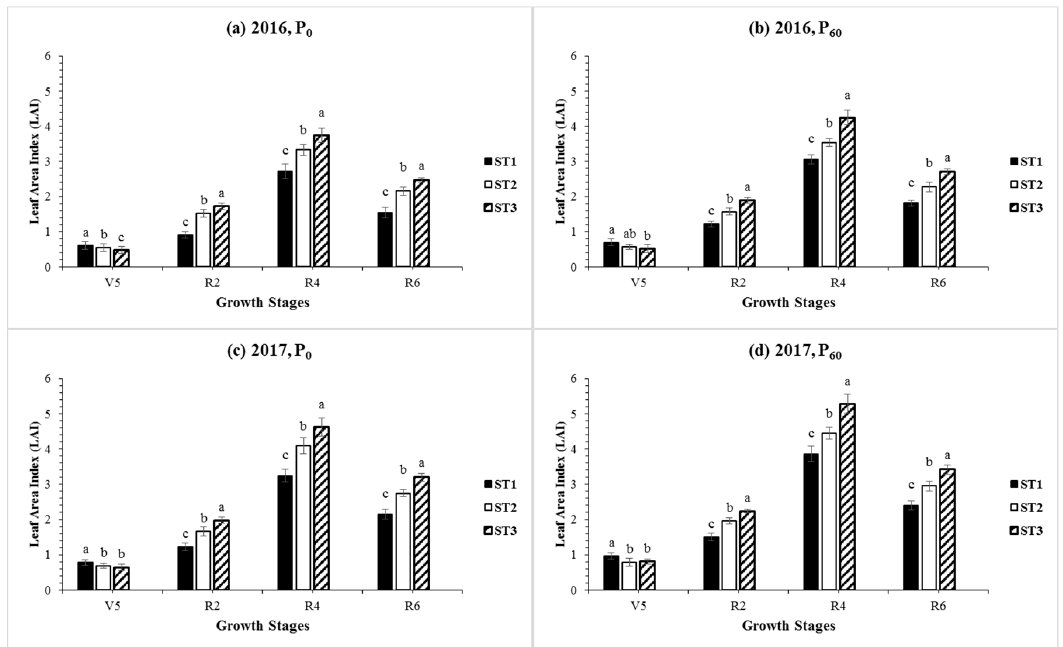
Figure 1 . Leaf area index of relay intercrop soybean as affected by three different sowing times at two rates of phosphorus fertilizer (P 0 ; A and C , and P 60 ; B and D ) during the cropping seasons of 2016 and 2017. ST 1 , ST 2 , and ST 3 represents the sowing times 15–20 May (90 days of co ‐ growth period in maize soybean relay intercropping system (MSICS)), 5–10 June (70 days of co ‐ growth period in maize soybean relay intercropping system (MSICS)), and 25–30 June, (50 days of co ‐ growth period in maize soybean relay intercropping system (MSICS)), respectively. V 5 , R 2 , R 4 , and R 6 refer to five trifoliate, full flowering, full pod, and full seed phenological stages of soybean. The P 0 and P 60 refer to 0 and 60 kg phosphorus ha − 1 , respectively. Means are averaged over three replicates. Bars indicate ± standard errors, ( n = 3). Between bars in groups, different lowercase letters indicate a significant difference ( p < 0.05) between treatments.